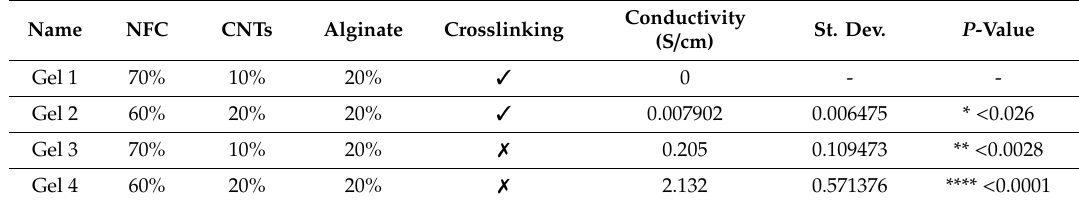
Table 1. Analysis of the e ff ect of crosslinking on conductivity and evaluation of conductive properties of sca ff olds composed of either 10% or 20% of CNTs. Crosslinking seems to produce loss of conductive e ff ect of CNTs, while non-crosslinked sca ff olds have good conductivity (0.12 and 1.9 S / cm, respectively, for 10% and 20% of